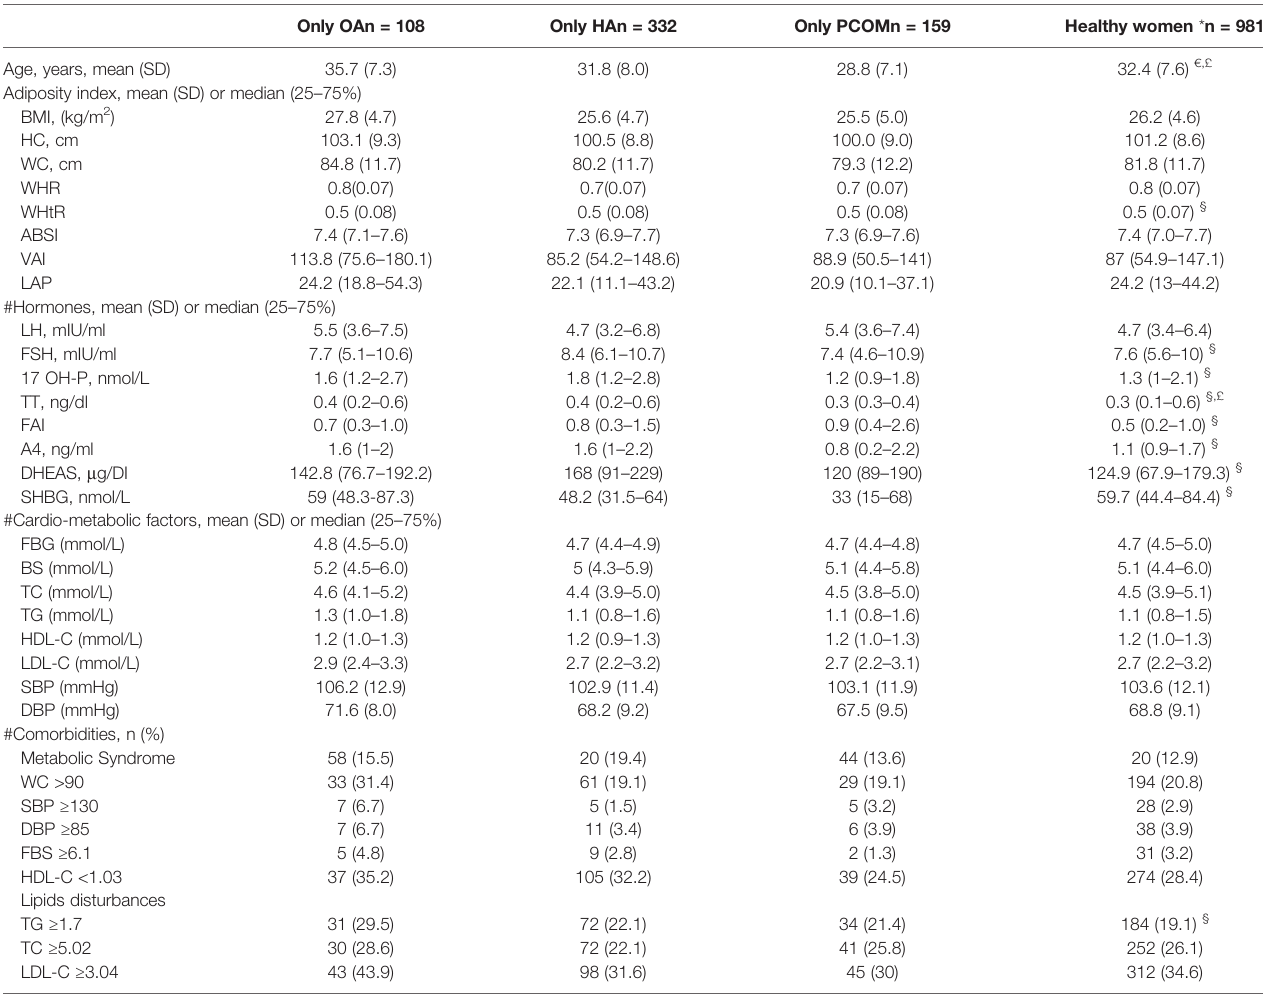
TABLE 3 | Features of the study characteristics classi fi ed to PCOS or those with one criteria of PCOS groups and healthy women. Only OAn =